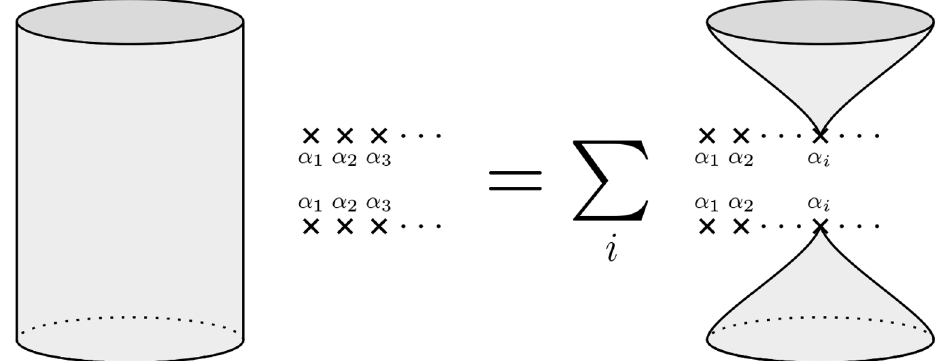
\ Figure 3 . CGHS version of the “wormhole = diagonal” identity which follows from the factorization of the two-point function in an α -state. A cross α i corresponds to the insertion of the operator O α and can be viewed as a coherent superposition of fixed energy boundaries. There is also a sum over all cylinders connecting every pair of free crosses in each line (but not crosses on different lines) which we have not represented